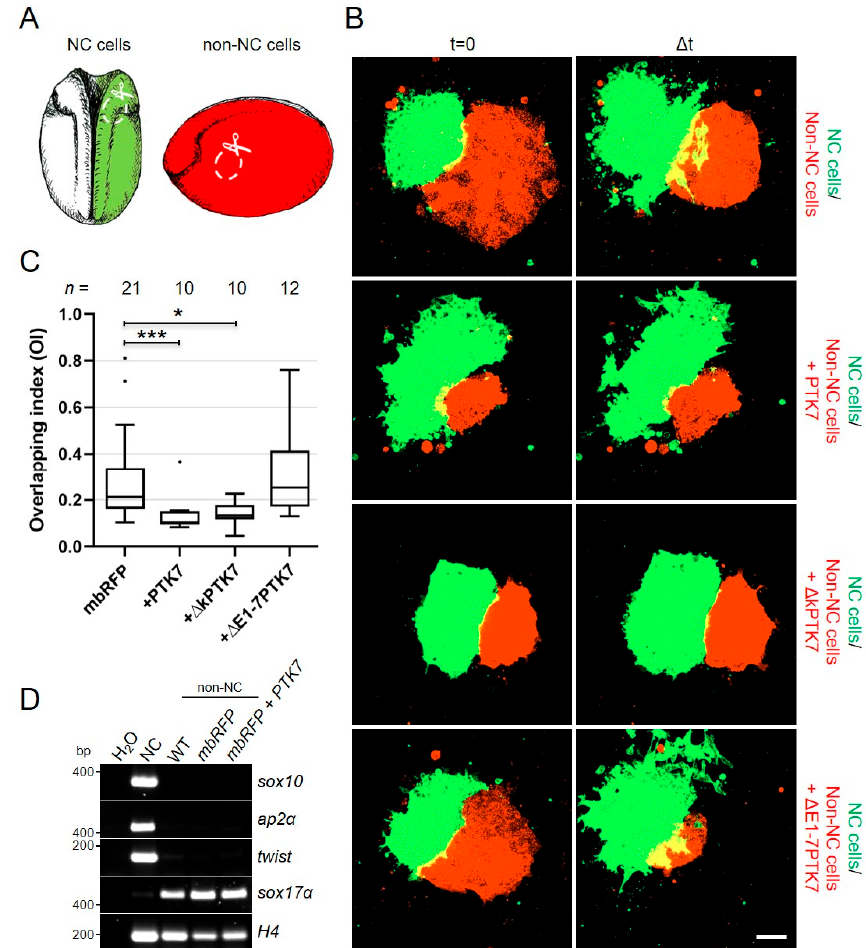
Figure 7. The extracellular domain of Ptk7 protects non-NC tissue from NC cell invasion. ( A – C ) Embryos were injected with either 100 pg mbGFP RNA or 200 pg mbRFP RNA, alone or in combination with 500 pg PTK7, ∆ kPTK7, or ∆ E1-7PTK7 RNA, in one blastomere at the two-cell stage. ( A ) At early neurula stage, either green fluorescent NC cells or red fluorescent non-NC cells were dissected. NC cells were co-cultured with non-NC cells and analyzed by time lapse microscopy. ( B ) First column: confronted explants at the start of the experiment (time point t = 0). Second column: confronted explants at the time point of maximal invasion ( ∆ t ). Green fluorescent NC cells invaded red fluorescent control non-NC tissue (upper lane). Overexpression of PTK7 and ∆ kPTK7 in non-NC explants prevented NC cell invasion (middle lanes). Non-NC tissue expressing ∆ E1-7PTK7 was invaded by NC cells (bottom panel) as it was observed in the control. Scale bar = 100 µ m. ( C ) Box plot showing overlapping indexes (OI) of NC explants confronted with non-NC tissue expressing mbRFP alone or in combination with various Ptk7 deletion constructs. Overexpression of PTK7 and ∆ kPTK7, but not ∆ E1-7PTK7, significantly decreased the OI. Number of analyzed confrontation events of at least three independent experiments is indicated for each column. The box extends from the 25th to the 75th percentile, with whiskers with maximum 1.5 IQR. The median is plotted as a line inside the box. * p < 0.05, *** p < 0.005 (Kruskal–Wallis test). ( D ) Marker expression of the explanted tissue was determined by performing RT-PCR utilizing the NC marker sox10, ap2 α , and twist as well as the endoderm marker sox17 α . Amplification of histone H4 ( H4 ) was used as an internal